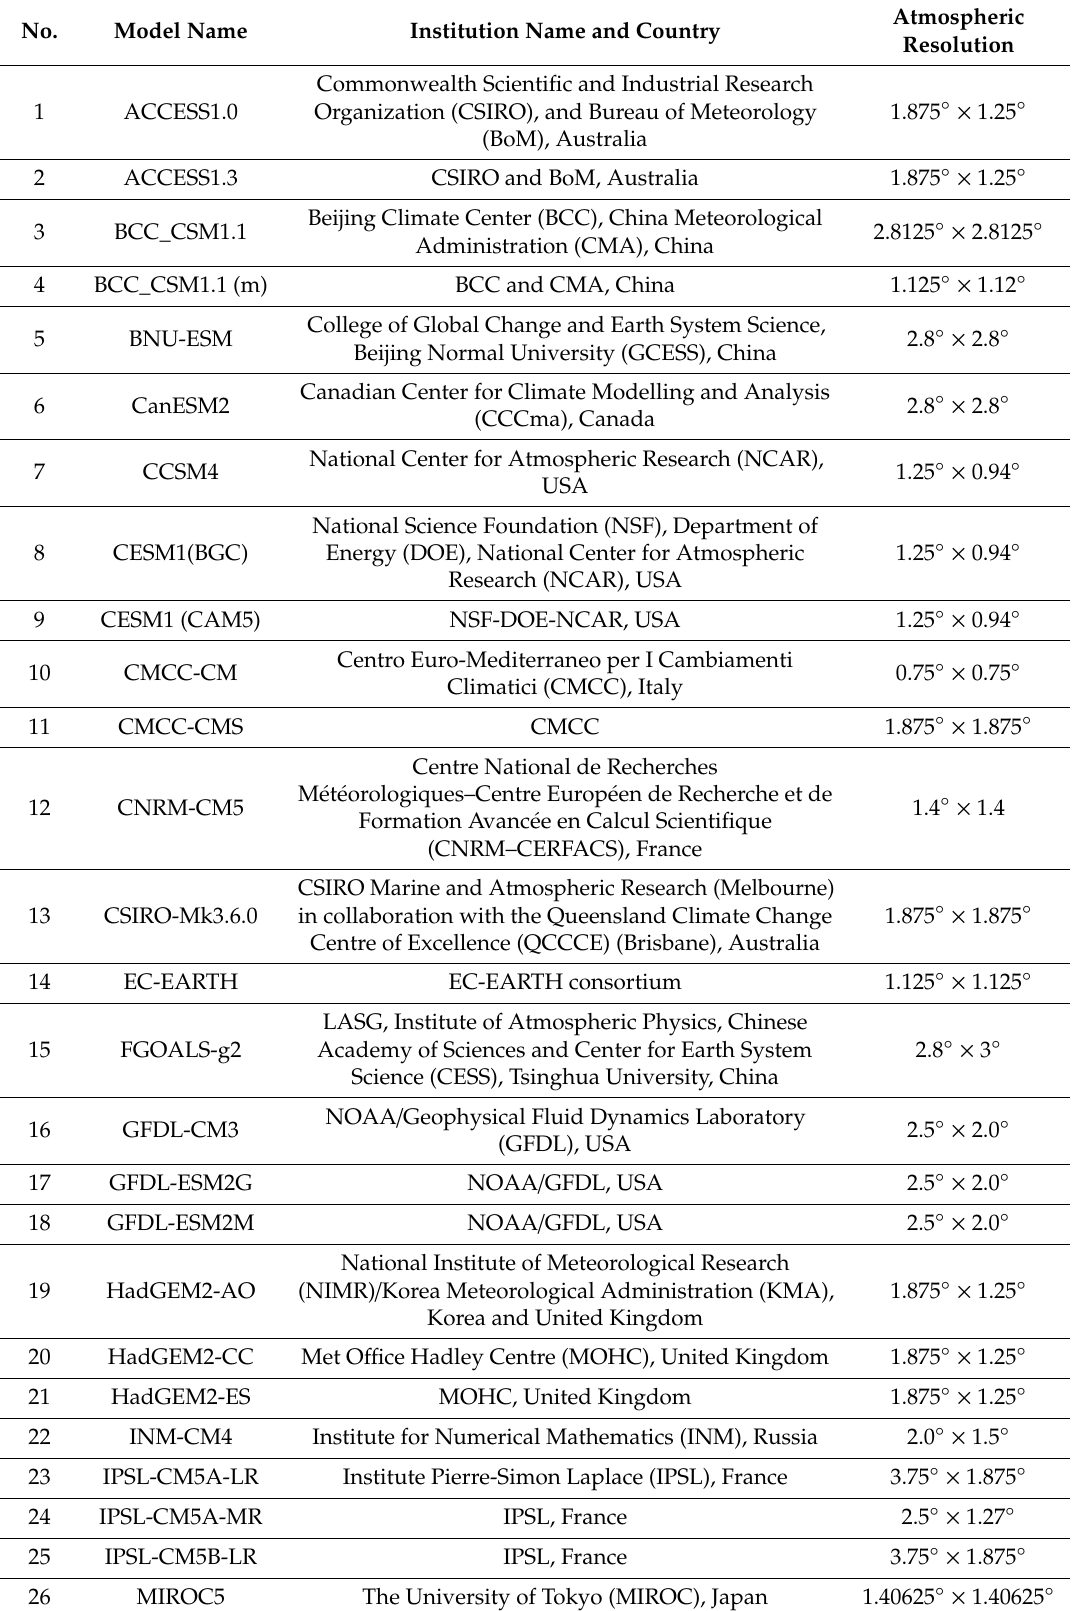
Table 1. Information of the 32 CMIP5 climate models used in this